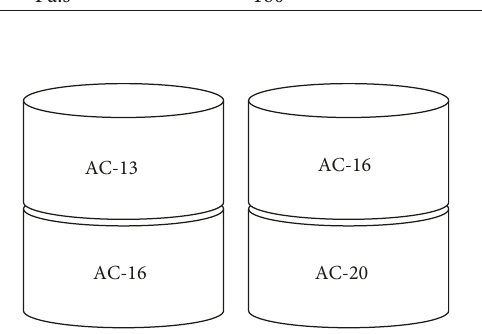
Figure 1: Structure of specimen. Table 2: Technical indexes of aggregate.